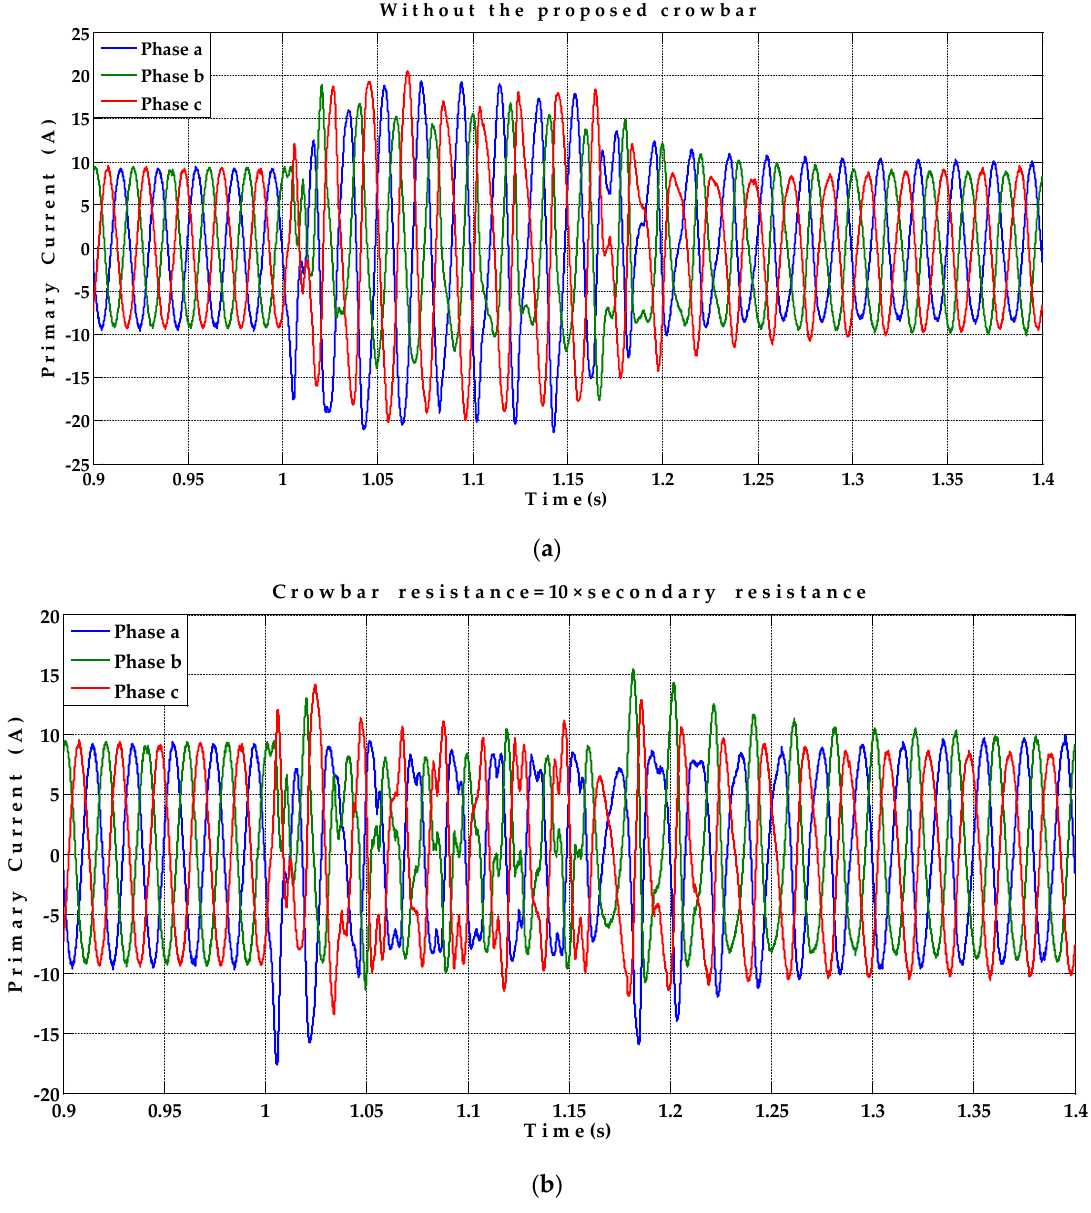
Figure 26. Primary current of BDFRG without and with the proposed crowbar under line to line fault occurrence: ( a ) Without the proposed crowbar; ( b ) With the proposed crowbar.